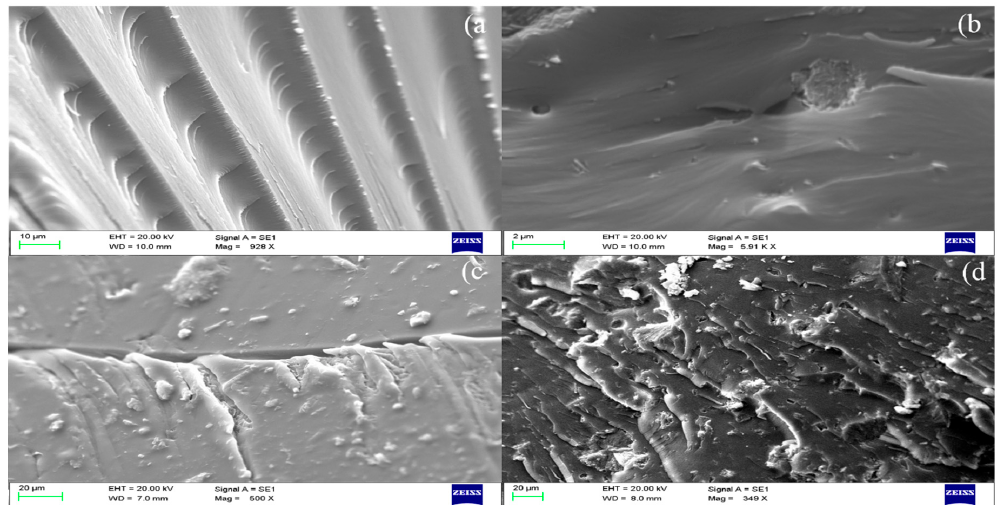
Figure 6. SEM images of the fractured surfaces of dental composite specimen without glass filler, at different magnifications: control group ( a ), composite with 2.5 wt.% HNT/CHX ( b ), composite with 5 wt.% HNT/CHX ( c ) and composite with 10 wt.% HNT/CHX focused on the Halloysite agglomerates ( d ).